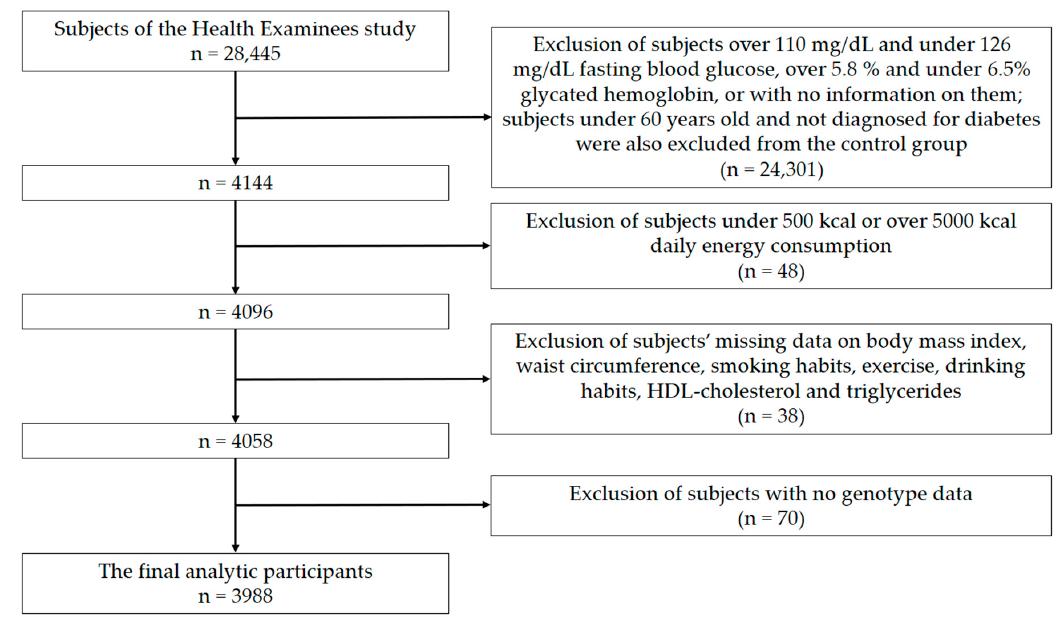
Figure 2. Flowchart of the study population.